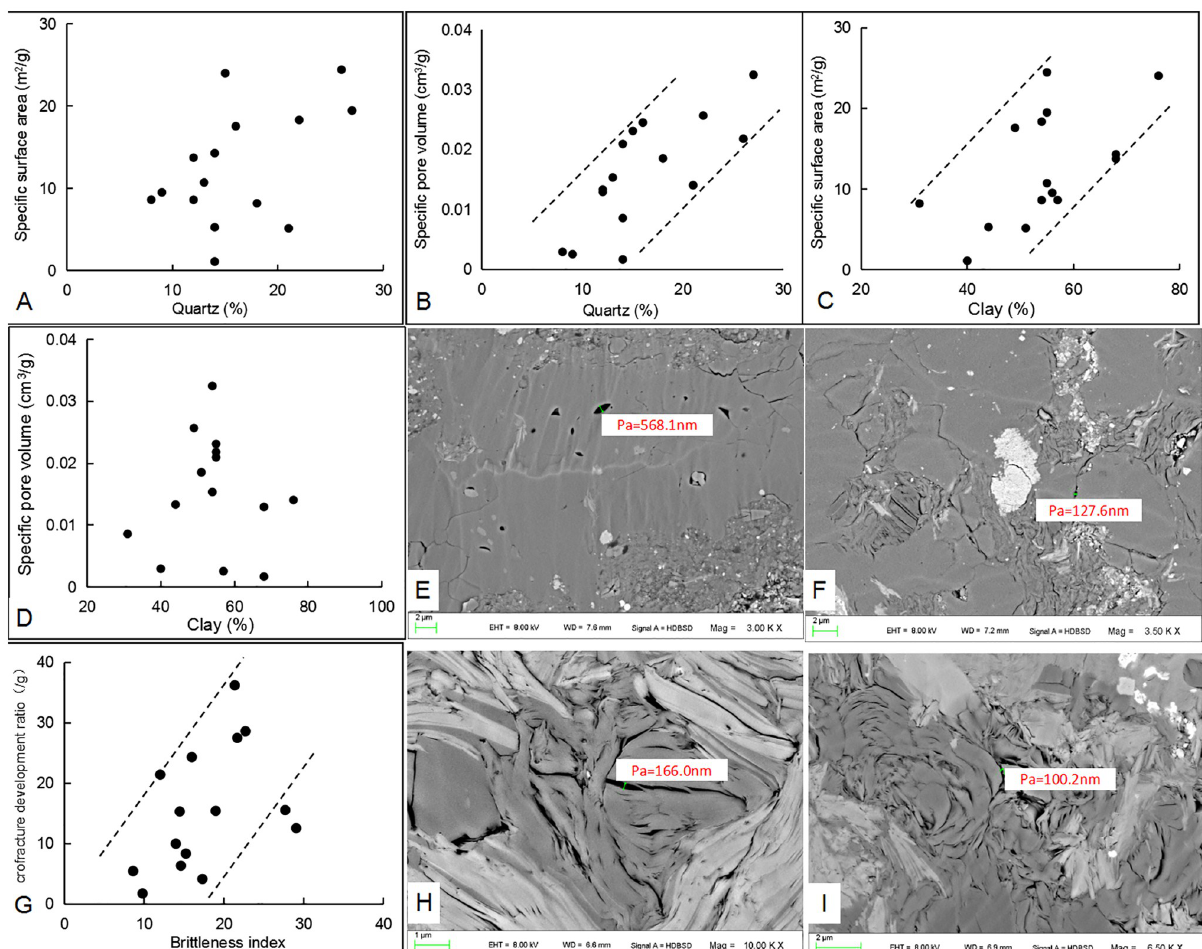
Fig 10. Relationships between different mineral components (quartz, clay minerals) and pore volume, specific surface area, and microfracture development ratio. (A) Relationship between quartz and specific surface area; (B) Relationship between quartz and specific pore volume; (C) Relationship between clay minerals and specific surface area; (D) Relationship between clay minerals and specific pore volume; (E) An irregular pore and microcrack in microgranular quartz ( × 3000); (F) Particle margin fractures in microcrystalline quartz (siliceous) ( × 3500); (G) Correlation between microfracture development ratio and brittleness index; (H) Interbedded fracture in lamellar andreattite aggregation ( × 10000); (I) Interlayer pores in alternately distributed lamellar andreattite and chlorite aggregation ( × 6500).